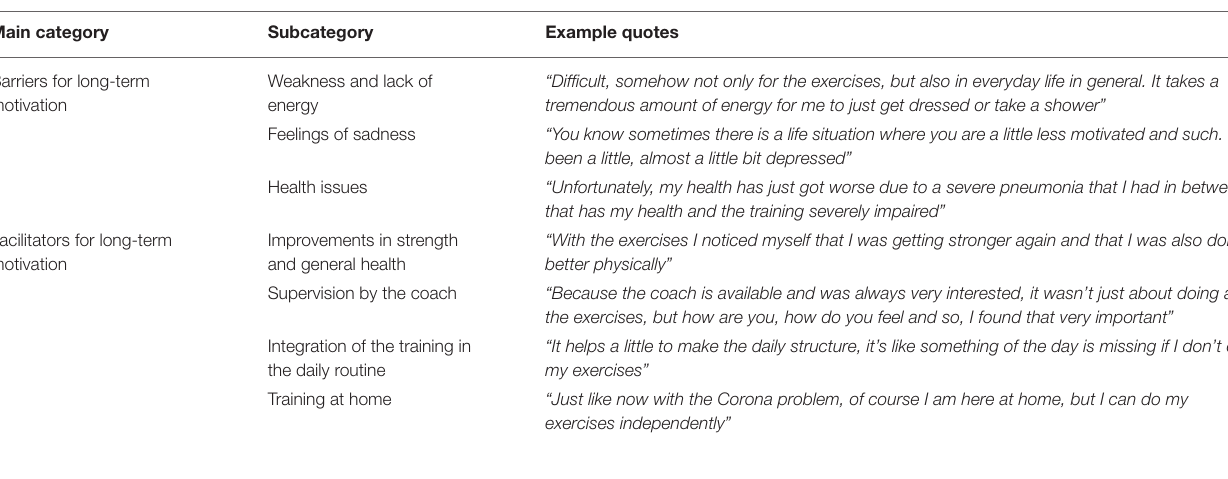
TABLE 3 | Results from interviews of patients: Long-term motivation. Main